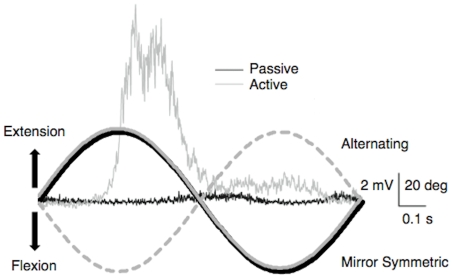
The active-passive movement protocol.Average left (active) and right (passive) FCR EMG traces from a single participant (1 s of data, average of 60 traces). For clarity EMG is shown from a mirror symmetric condition only. The marked difference in EMG activity can be seen between the active FCR (grey trace) and passive FCR (black trace) during the movement. A schematic of passive (black trace) and active wrist angle from mirror symmetric and alternating session of Exp 1 is shown.